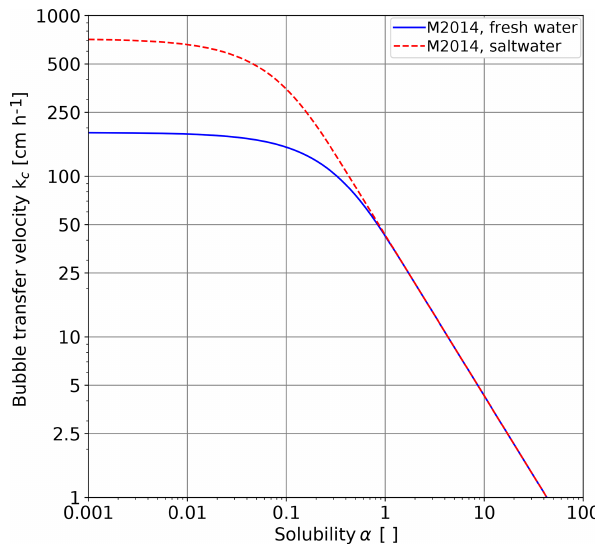
Figure 2. Dependency of bubble-mediated gas transfer velocities for the tracers covering a wide range of solubilities as measured in a bubble tank in which breaking waves were simulated by a wa- ter jet for fresh water and seawater (Mischler, 2014). The jet en- ergy was 3.3W and the bubble volume flux kept constant at about 750mLmin − 1 , corresponding to k r = 43cmh − 1